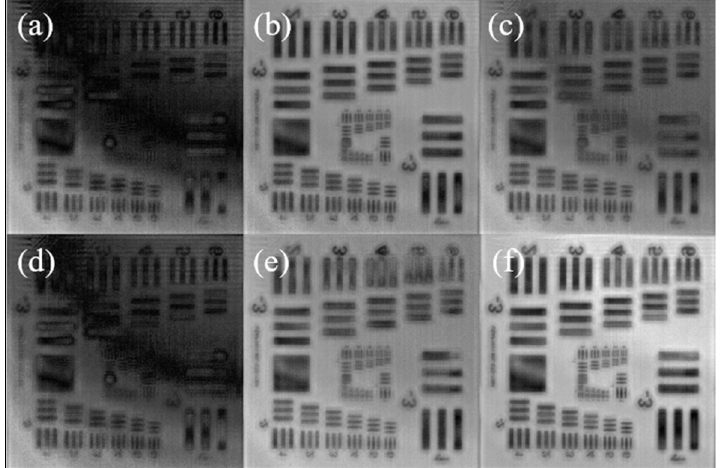
Figure 13. The restored THz imaging. ( a ) The original image of channel 10; ( b – f ) the restored THz image via Tikhonov, GRNN, CNN, SG filter, and the proposed method.